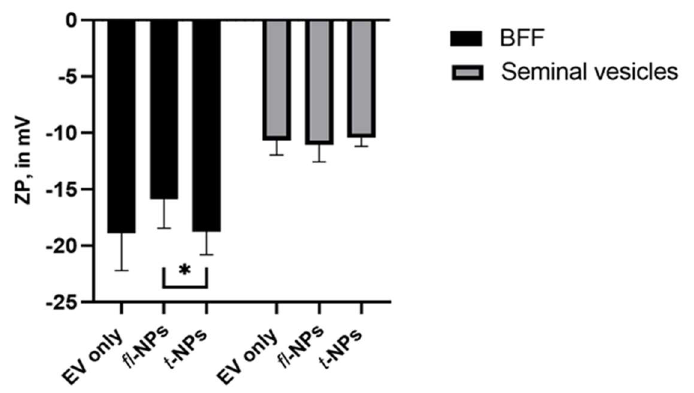
Figure 12. Zeta potential of fluorescent and total NPs for BFF and seminal plasma-derived EVs purified in SEC. All EV types were labeled with 100 ng/mL of CMG and fl- NPs were measured at a minimum brightness threshold value of 25. The ZP value for fl- NPs of BFF EVs was significantly different ( p ≤ 0.05) than the corresponding t-NPs of BFF. Thus, were marked with an asterisk (*) symbol. The zeta potential for respective EV only controls, fl- , and t-NPs of BFF and seminal plasma- derived EVs measured in fluorescent and scatter modes of NTA. EVs were diluted in 1 × PBS, and the ZP measurement was done at a neutral pH of 7.2 (mean ± SD, n = 9).